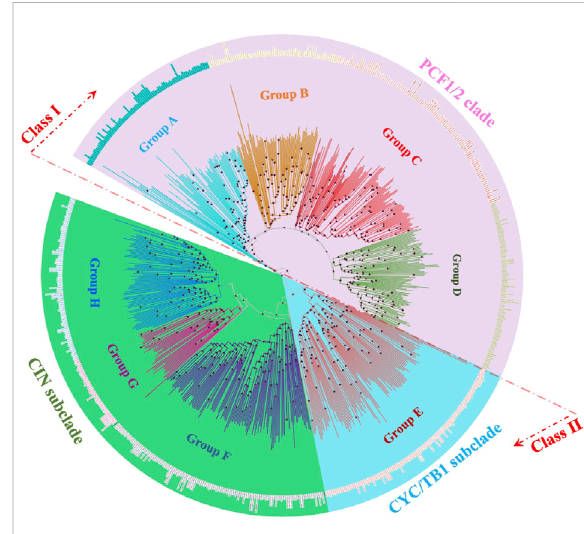
FIGURE 3 Evolutionary relationships of TCP subgroups in 28 plant species.Anunrootedneighbour-joiningtreewasconstructedwith the trimmed multiple sequence alignment of MEGA 11. The phylogenywasconstructedusing1,000bootstrapreplication value,bootstrapvaluesoflessthan70%areindicatedbyredcircles on tree branches. Groups A-H were designated according to ancestral relationship of different branches and their clockwise appearancewithineachtree.Groupsaredistinguishedbydifferent branch color